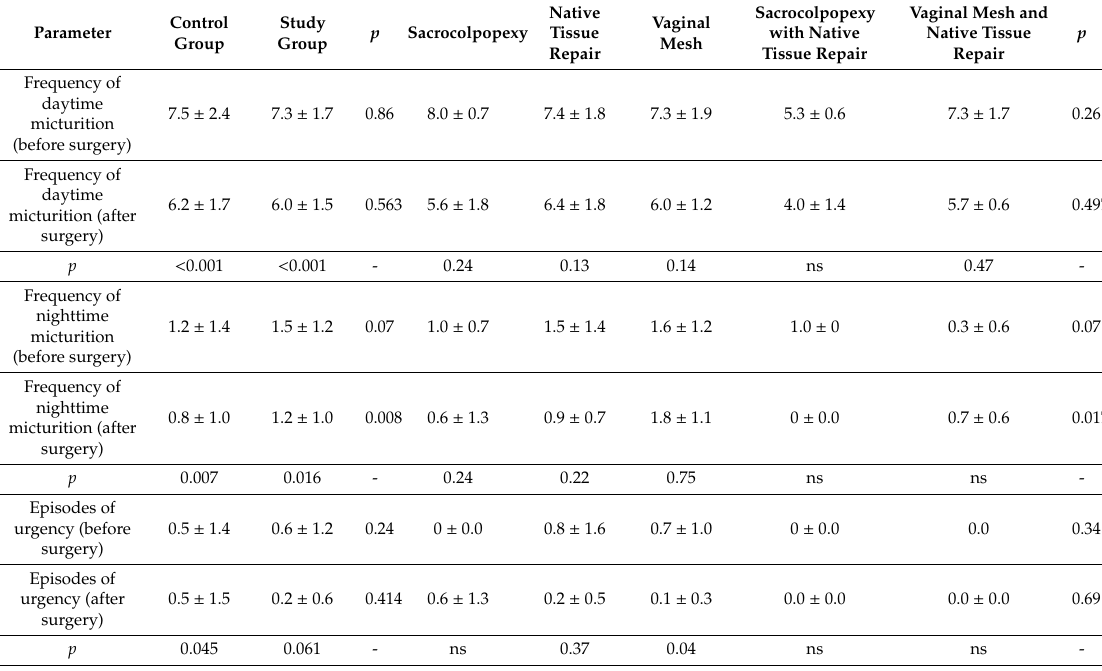
Table 7. OAB symptoms before and after the sling procedure in both groups, with regard to the type of reconstructive